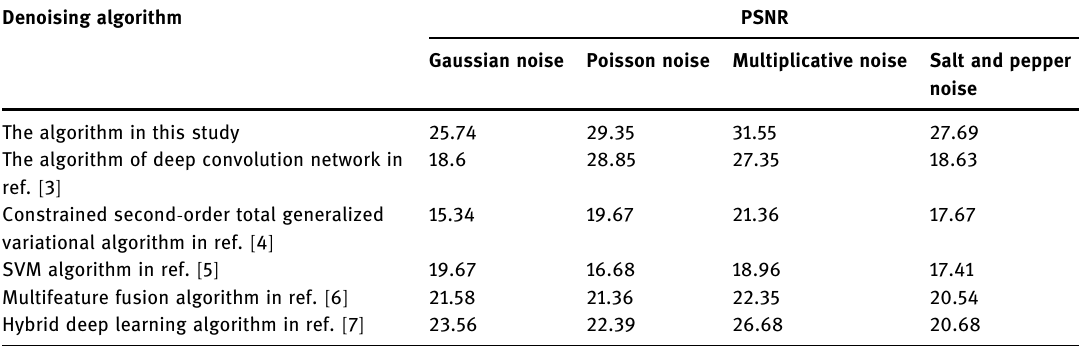
Table 1: Image noise after algorithm processing